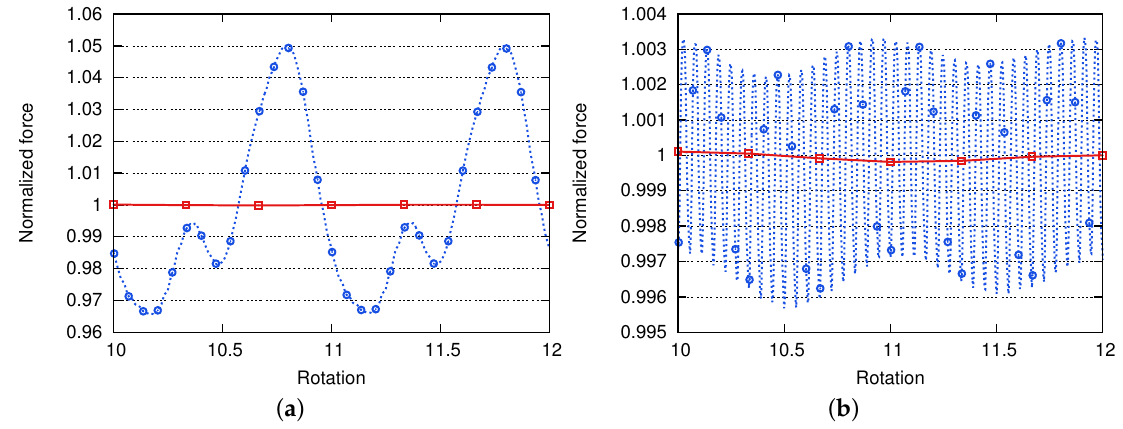
Figure 4. Evolution of one fan-blade force ( a ) and one OGV force ( b ) normalized by their converged mean values: instantaneous evolution in blue dotted lines marked with circles and sliding average in red solid lines marked with